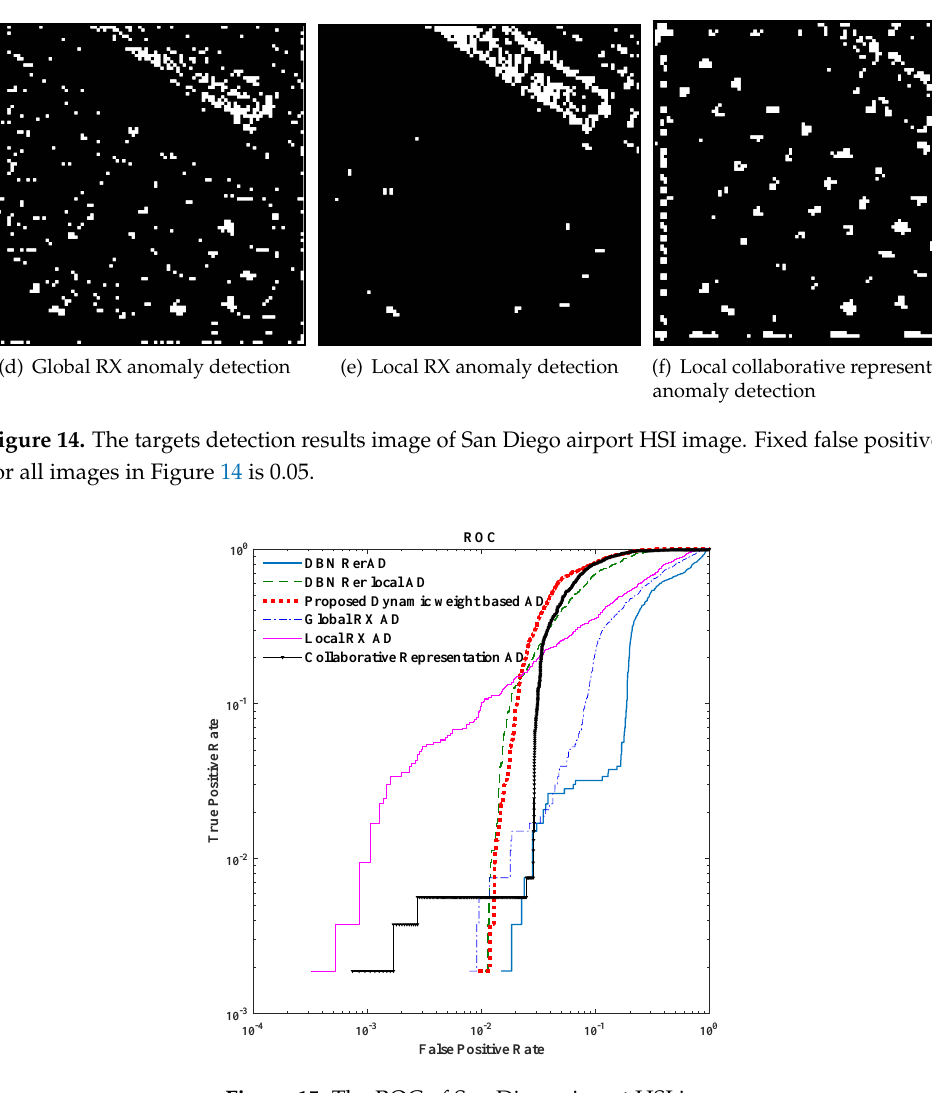
Figure 15. The ROC of San Diego airport HSI